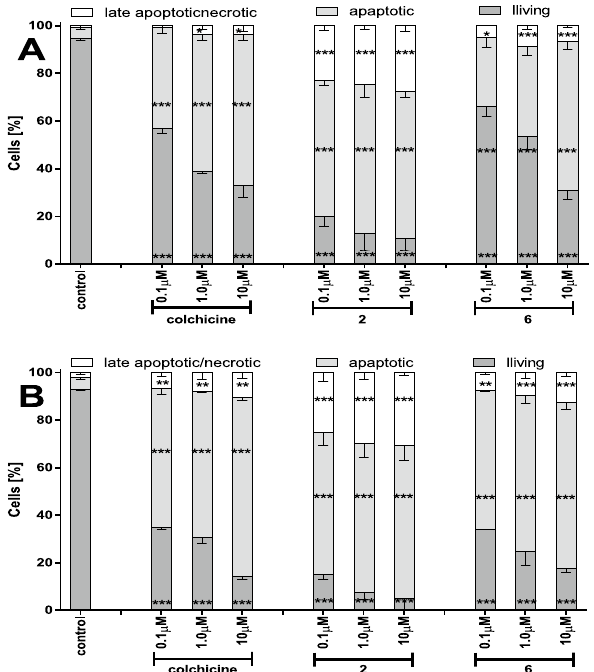
Figure 4. Apoptosis induction in SKOV-3 treated with compounds: 1 , 2 and 6 at concentrations 0.1 μM, 1.0 μM, and 1.0 μM for 24 h ( A ) and 72 h ( B ). After incubation cells were stained with stained Hoechst 33,258 and propidium iodide and evaluated using fluorescence microscopy. Statistical significances are marked with asterisks (*) p < 0.05; (**) p < 0.01; (***) p < 0.001.